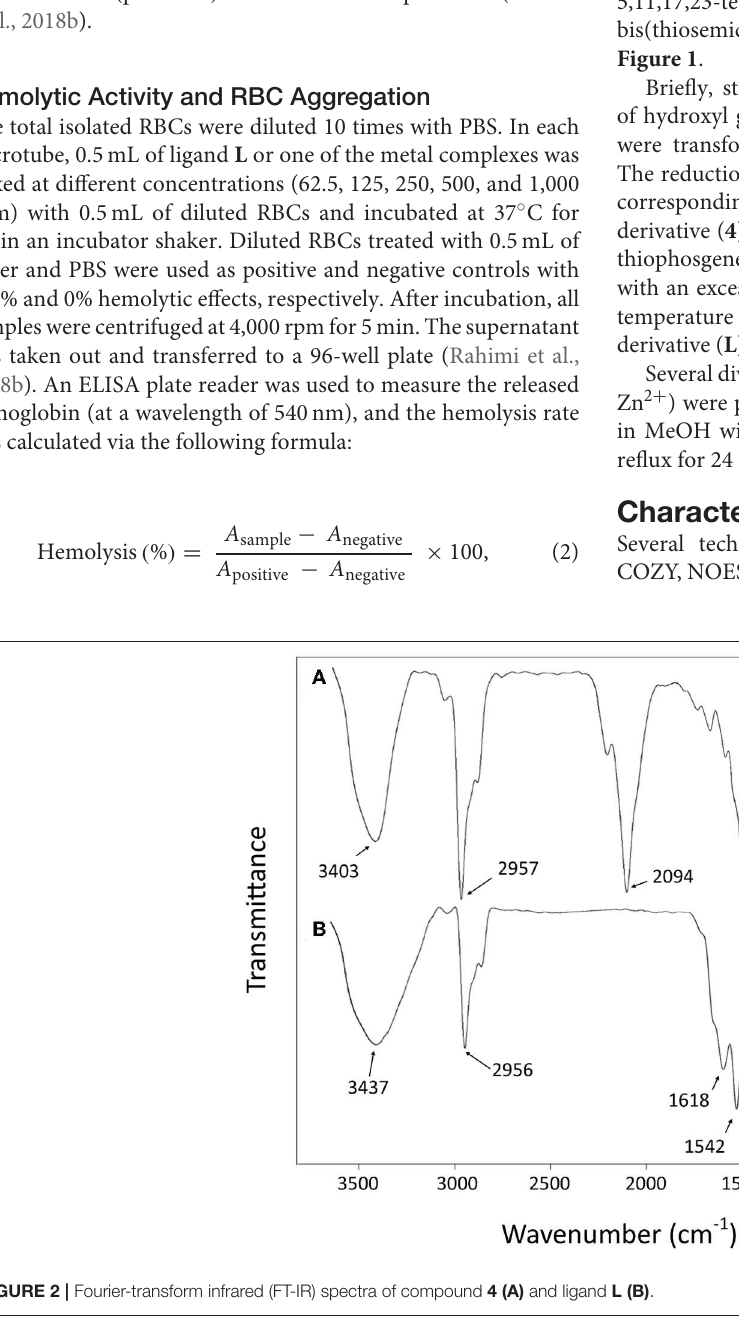
Frontiers in Chemistry |